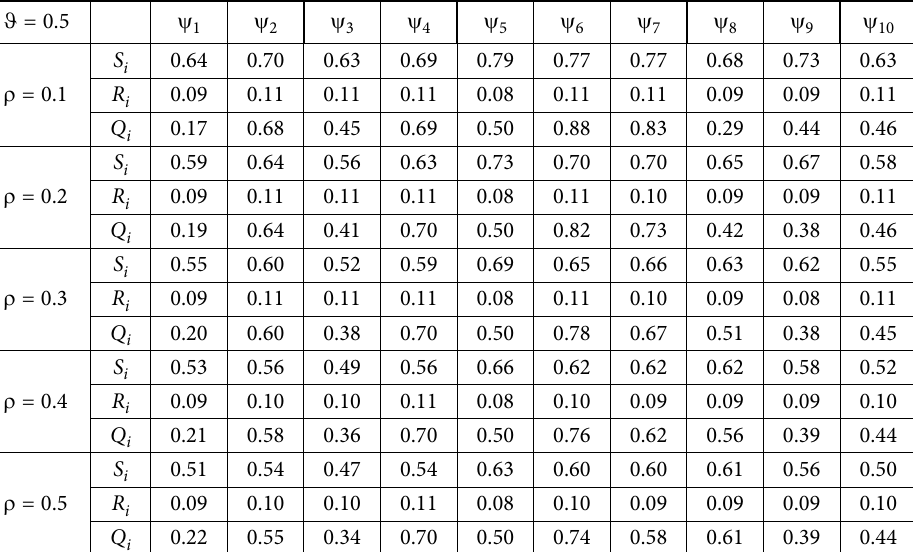
Table 10. The final results with J = 0.5 and r ∈ [0,1] J =